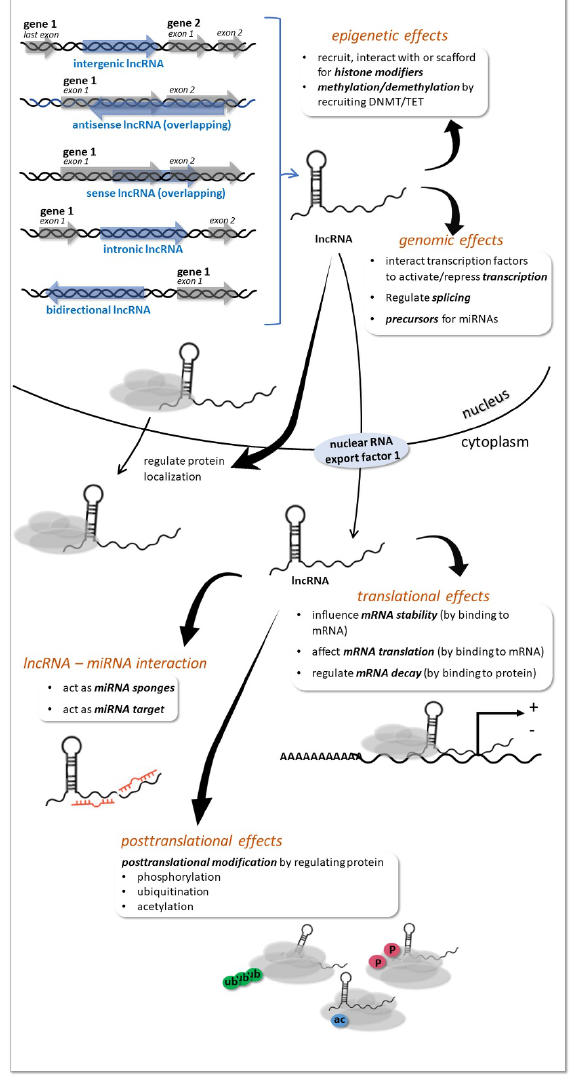
Figure 3. Biogenesis and function of lncRNAs (see details in the text) .